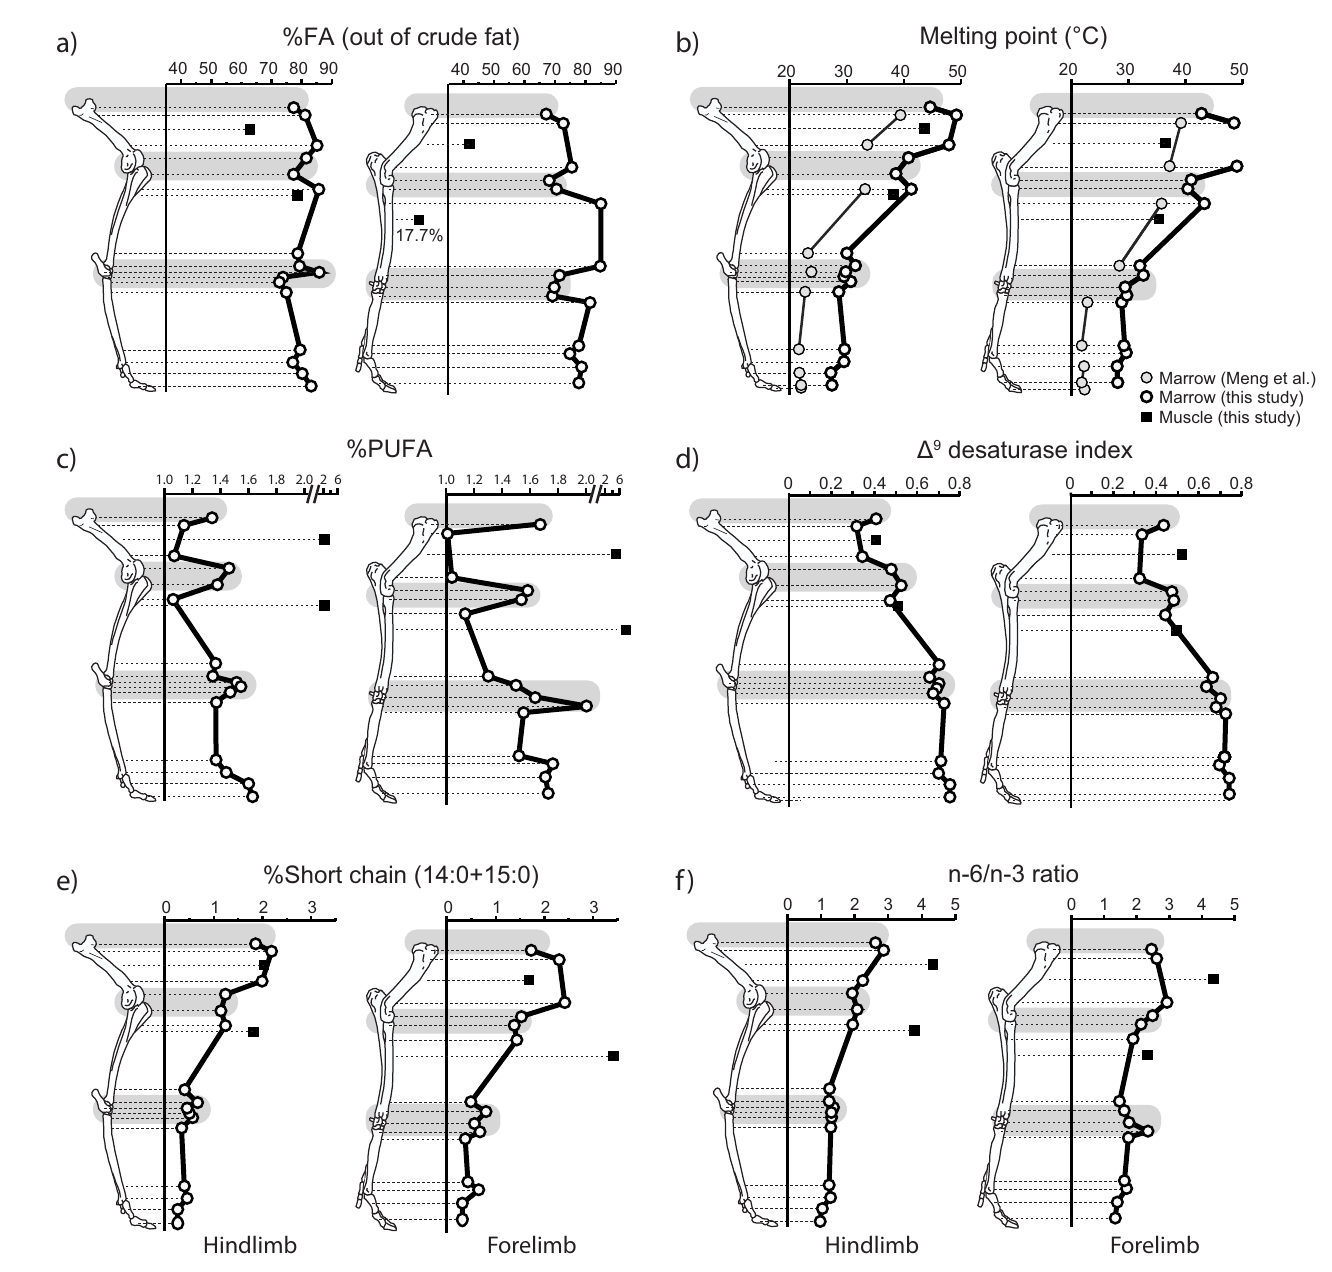
Fig 3. Fatty acid (FA) composition in the caribou limbs. a) percentage of FA (calculated out of crude fat); b) weighted melting point; c) percentage of polyunsaturated FA (PUFA); d) Δ 9 desaturase index; e) %short chain saturated FA; f) n-6/n-3 FA ratio. Note the change of scale in c). The shaded areas correspond to areas of suspected significant hematopoiesis. The data points correspond to the mean for the two animals. The summed percentage of PUFA (% PUFA) includes these FA: cis -9,12 18:2; cis -9,12,15 18:3; cis -6,9,12,15 18:4; cis -11,14 20:2; cis -8,11,14 20:3; cis -5,8,11,14 20:4; cis -5,8,11,14,17 20:5; cis -7,10,13,16 22:4; cis -4,7,10,13,16 22:5; cis -7,10,13,16,19 22:5; cis -4,7,10,13,16,19 22:6. The percentage of short chain saturated FA (%short chain saturated FA) is the sum of 14:0 and 15:0. The Δ 9 desaturase index was derived as follows: ( cis -9 14:1 + cis -9 16:1 + cis -9 18:1)/(14:0 + cis -9 14:1 + 16:0 + cis -9 16:1 + 18:0 + cis -9 18:1). The n-6/n-3 ratio was obtained using this equation: n-6 PUFA/n-3 PUFA. Data from Tables 2, 3 and (S1 File). The comparative melting point data shown in b) were derived from Meng et al. [4]. The individual melting points used in the calculation of the weighted melting points (including those used in our conversion of Meng et al.’s data) are provided in the S1